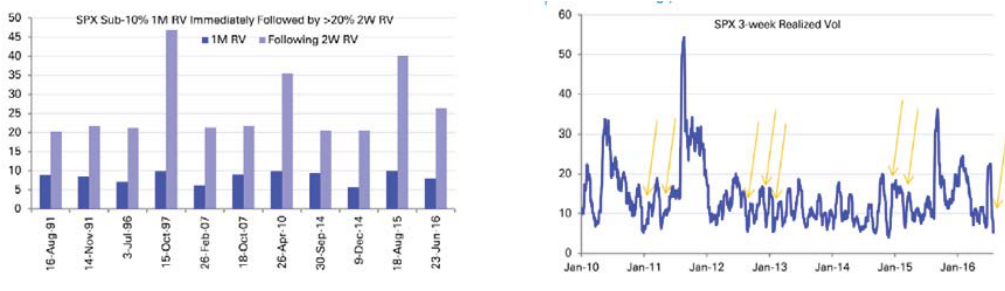
Fig. 2. Sudden drops in SPX realized volatility from high levels to very low levels have become increasingly common Source: Deutsche Bank, Bloomberg Finance